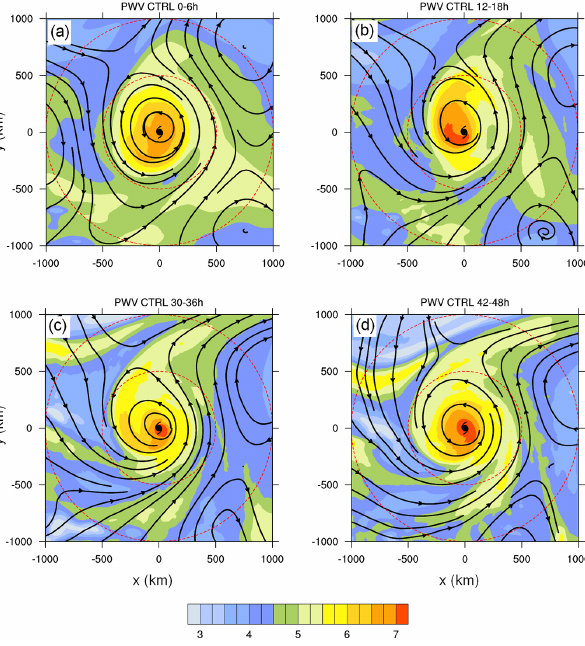
Figure 3. The mean translated streamline below 5km and column- integrated PWV (cm) (shading) in the WRF CTRL simulation in the storm-following coordinate: (a) 0–6h; (b) 12–18h; (c) 30–36h; (d) 42–48h. The hurricane symbol shows the TC center. The dashed red circles represent the radius of 500 and 1000km. All the data are taken from the outer model domain.